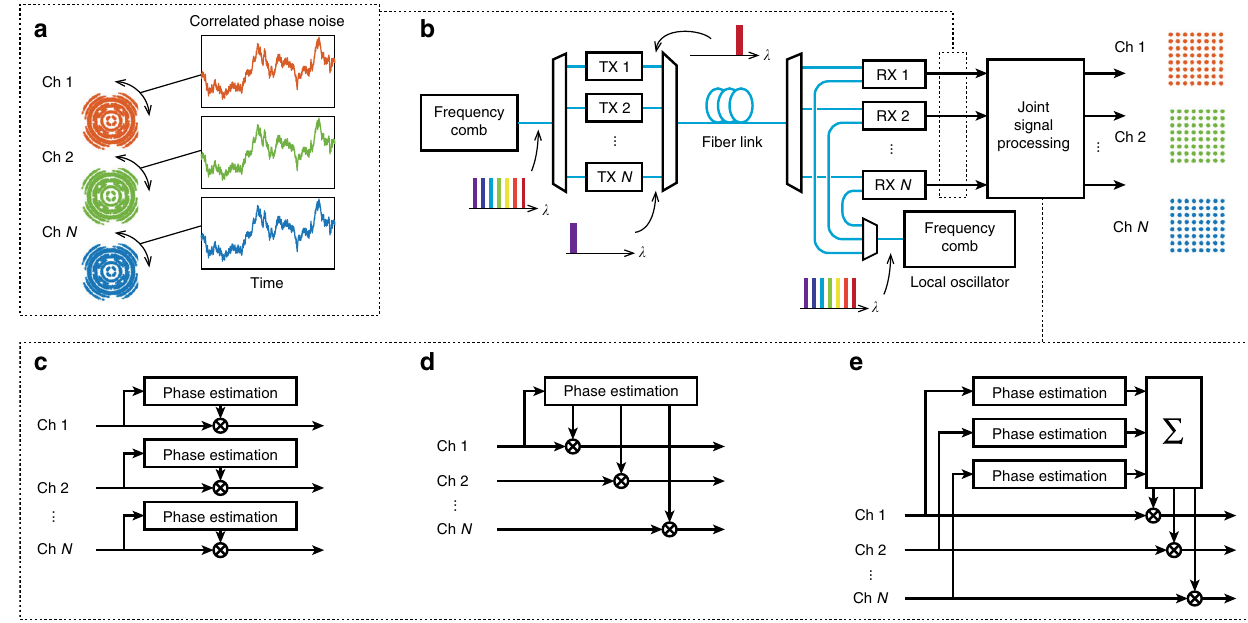
Fig. 1 Conceptual schematic of phase-coherent communications in wavelength division multiplexing. a Illustration of the signi fi cance of correlated phase noise in a transmission system. The constellation diagrams are distorted by the same phase noise, which enables joint phase processing. b The lines of a frequency comb are individually modulated and then transmitted together. In the receiver, a second frequency comb acts as a local oscillator. c Traditional carrier recovery with several redundant phase-estimation blocks. d Master-slave phase recovery. The phase noise is estimated from one channel and then applied to all channels, eliminating redundant phase-estimation blocks. e Joint phase estimation. By averaging the estimated phase noise over several channels, faster phase variations can be